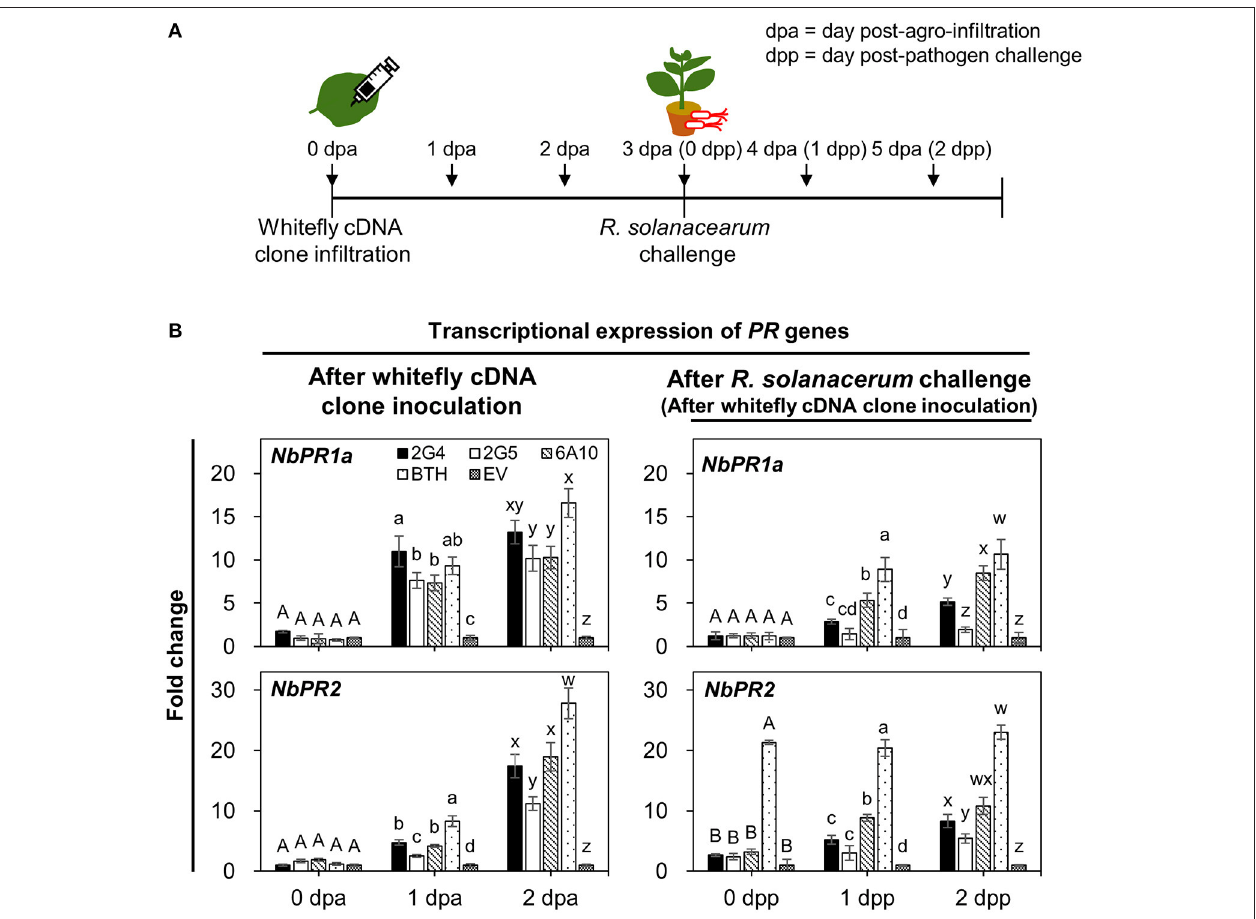
FIGURE 5 | Whitefly effector candidate-mediated defense priming of SAR marker genes in roots after challenge with Ralstonia solanacearum . (A) Schematic diagram of the experimental design for investigating the expression of SAR marker genes NbPR1a and NbPR2 after leaf infiltration with whitefly cDNA clones 2G4, 2G5, and 6A10 into three whole leaves and on days 0, 1, and 2 after R. solanacearum challenge. The samples used to investigate whitefly effector candidate-mediated direct systemic activation of SAR marker genes were root tissues collected after leaf infiltration with whitefly cDNA at 0, 1, and 2 days post- Agrobacterium infiltration (dpa). The samples for the defense priming experiment were root tissues collected after pathogen challenge at 0, 1, and 2 day post-pathogen challenge (dpp). (B) Quantification of the defense priming of SAR marker genes NbPR1a and NbPR2 in roots at 0, 1, and 2 days after inoculation with whitefly cDNA clones 2G4, 2G5, and 6A10 (left panel) and after challenge with R. solanacearum (right panel). Transcription is shown relative to empty vector (expression level = 1) with the NbActin gene as an internal reference. Bars represent the mean value ± SEM ( N = 10). Infiltration with 1mM BTH and Agrobacterium empty vector (EV) suspension was used as a positive and negative control, respectively. Different letters (A, B, a, b, c, and d; w, x, y, and z) within dpa and dpp indicate statistically significant differences ( P <